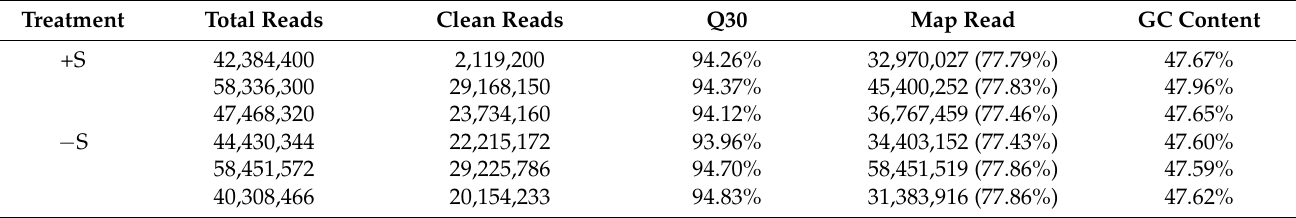
Table 2. Sequencing Data